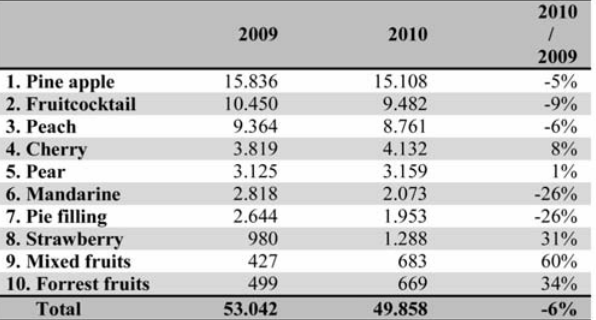
Figure 8. Supermarket Sales of fresh fruit in 2010 (value) Source: PT / Nielsen